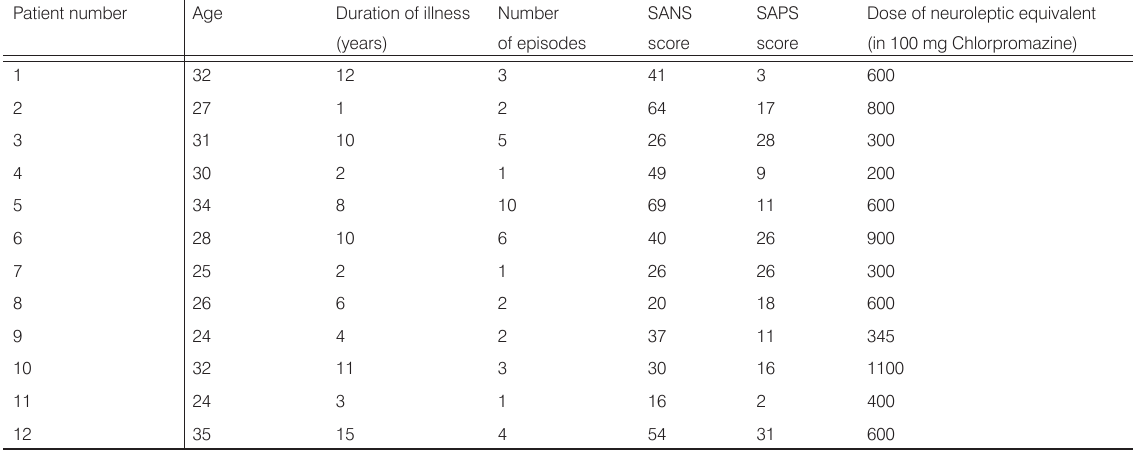
Table 1. Clinical characteristics of